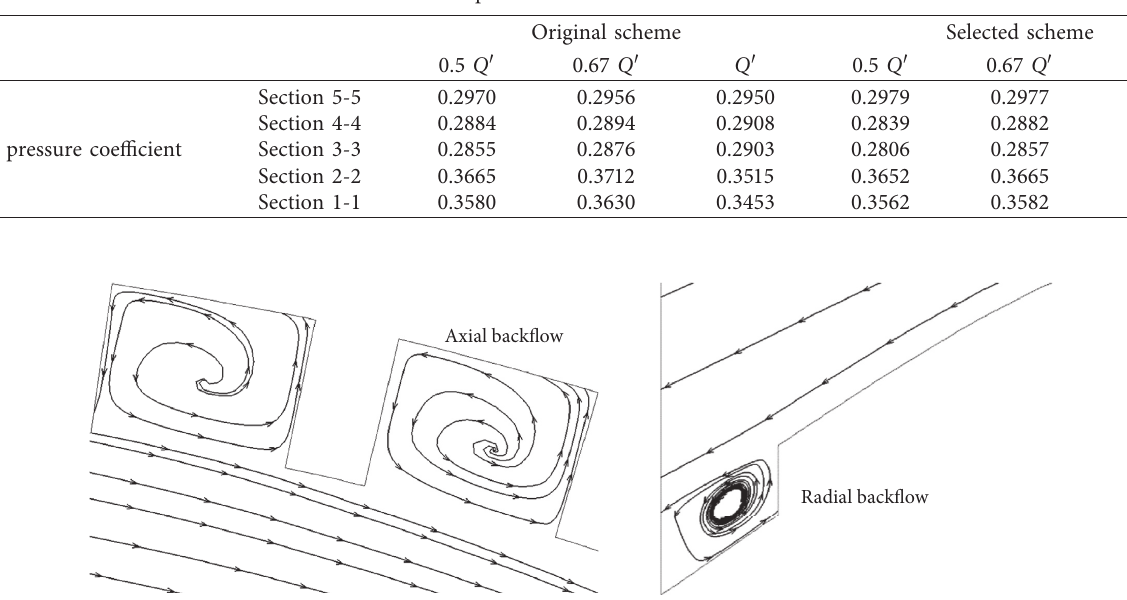
Figure 9: Streamlines in